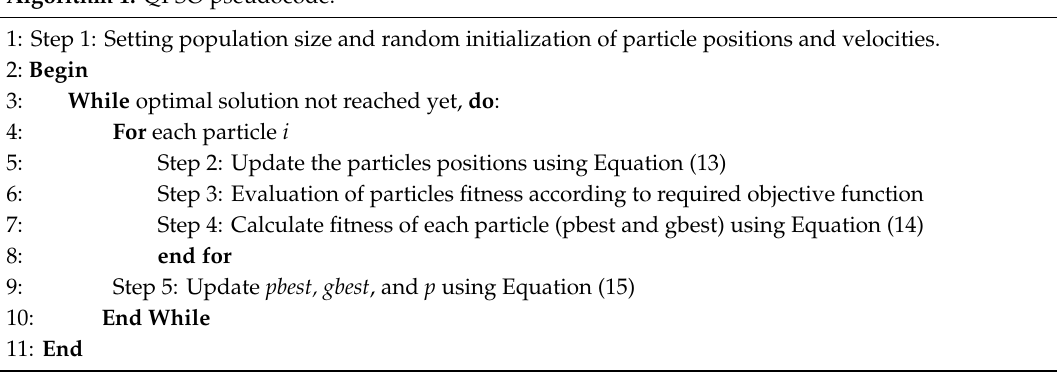
Algorithm 1. QPSO